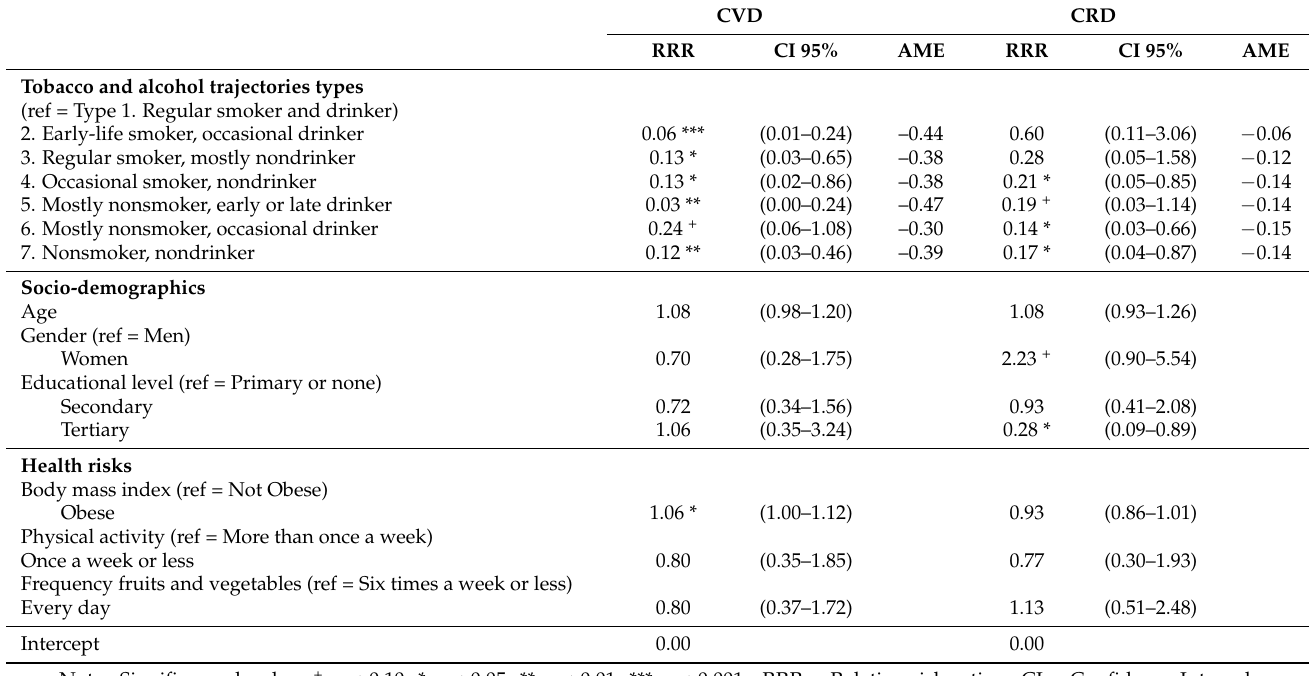
Table 3. Weighted logistic regression models over the probability of experiencing CVD and